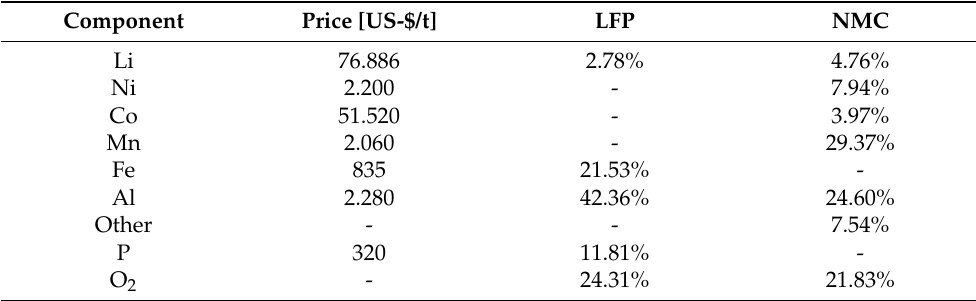
Table 1. Average composition of LFP and NMC cathode material and prices of the individual components [9,11,12]. Component Price [US-$/t]